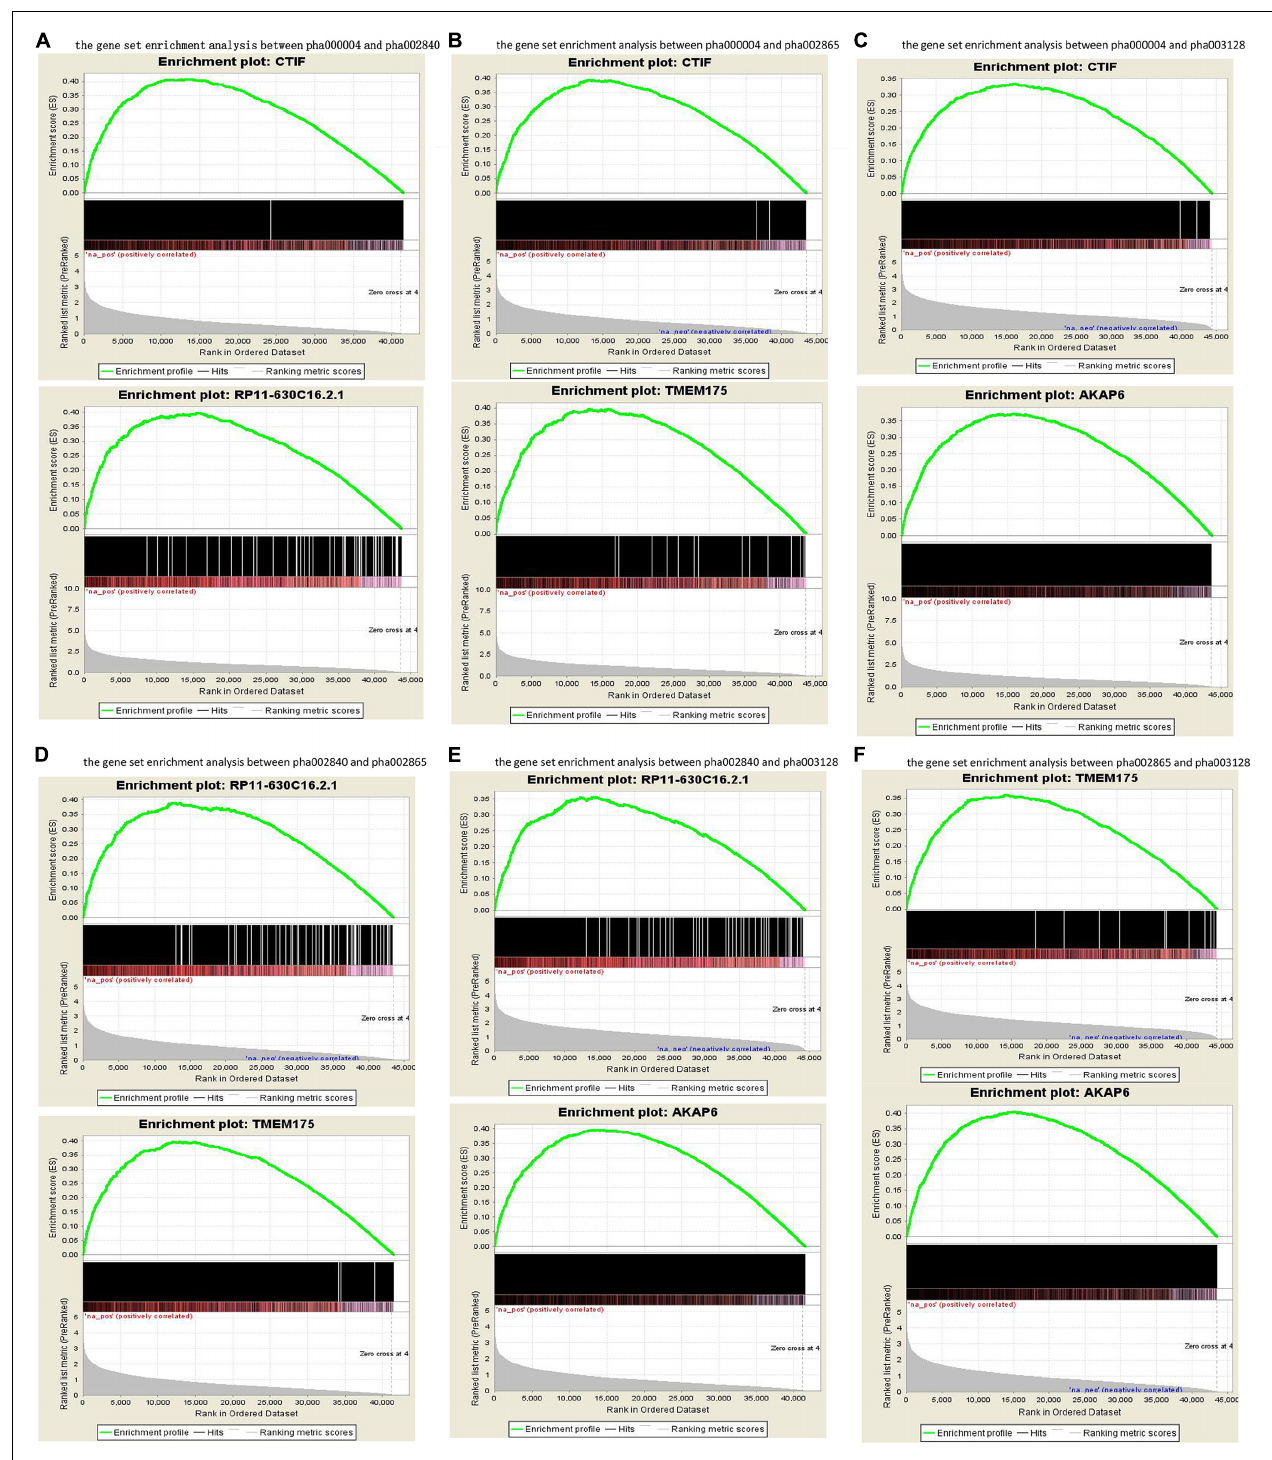
FIGURE 2 | Gene set enrichment analysis of the four GWAS datasets. Pairwise comparisons of gene sets from four studies were performed based on p -values. (A–C) pha000004 was enriched compared with pha002840 (A) , pha002865 (B) , and pha003128 (C) . (D,E) pha002840 was enriched compared with pha002865 (D) and pha003128 (E) . (F) pha002865 was enriched compared with pha003128. These results confirm the reproducibility of the four studies and indicate that similar molecular mechanisms of sPD-related genes were found in all of the studies. GWAS, genome-wide association study; sPD, sporadic Parkinson’s disease.